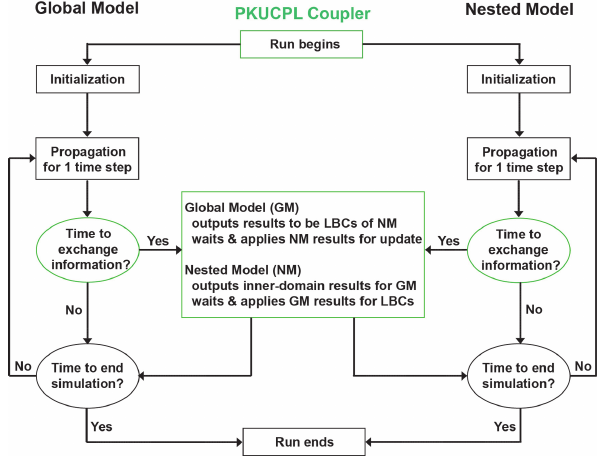
Figure 4. Flowchart of the two-way coupling process. Green in- dicates the key steps to achieve the two-way integration via the PKUCPL